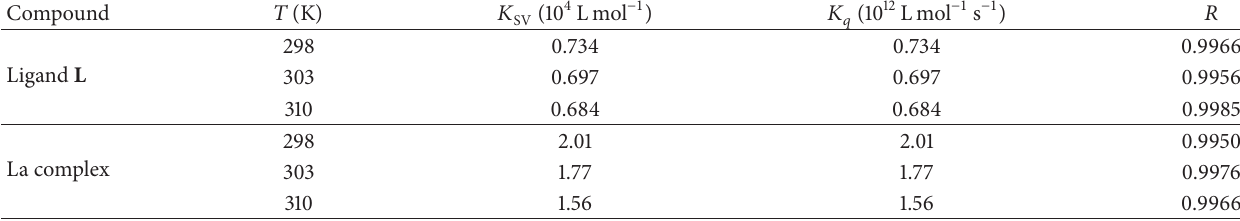
Table 2: The Stern-Volmer quenching constants of system at various temperatures.